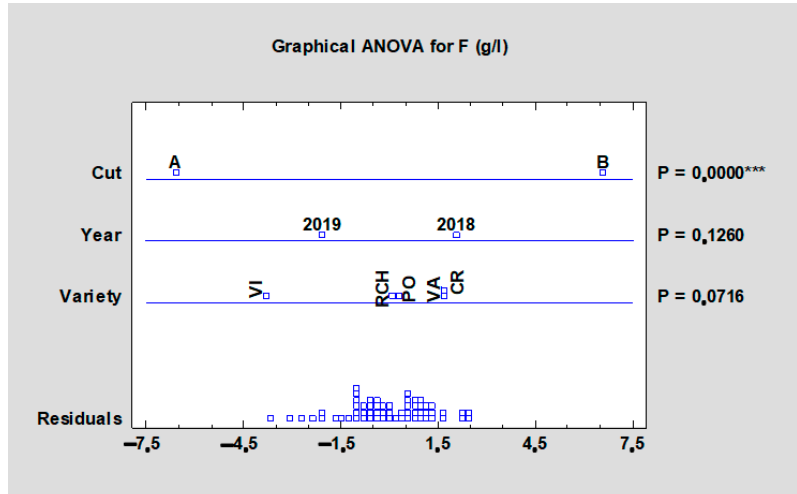
Figure 4. Effect of the experimental year, cultivar, and term of the harvest on the mean fructose content of all rhubarb cultivars. Abbreviations: PON, ‘Poncho’; CRE, ‘Canadian Red’; VAL, ‘Valentine’; RCH, ‘Red Champagne’; VIC, ‘Victoria’. LSD test with significance p ≤ 0.001 (***).